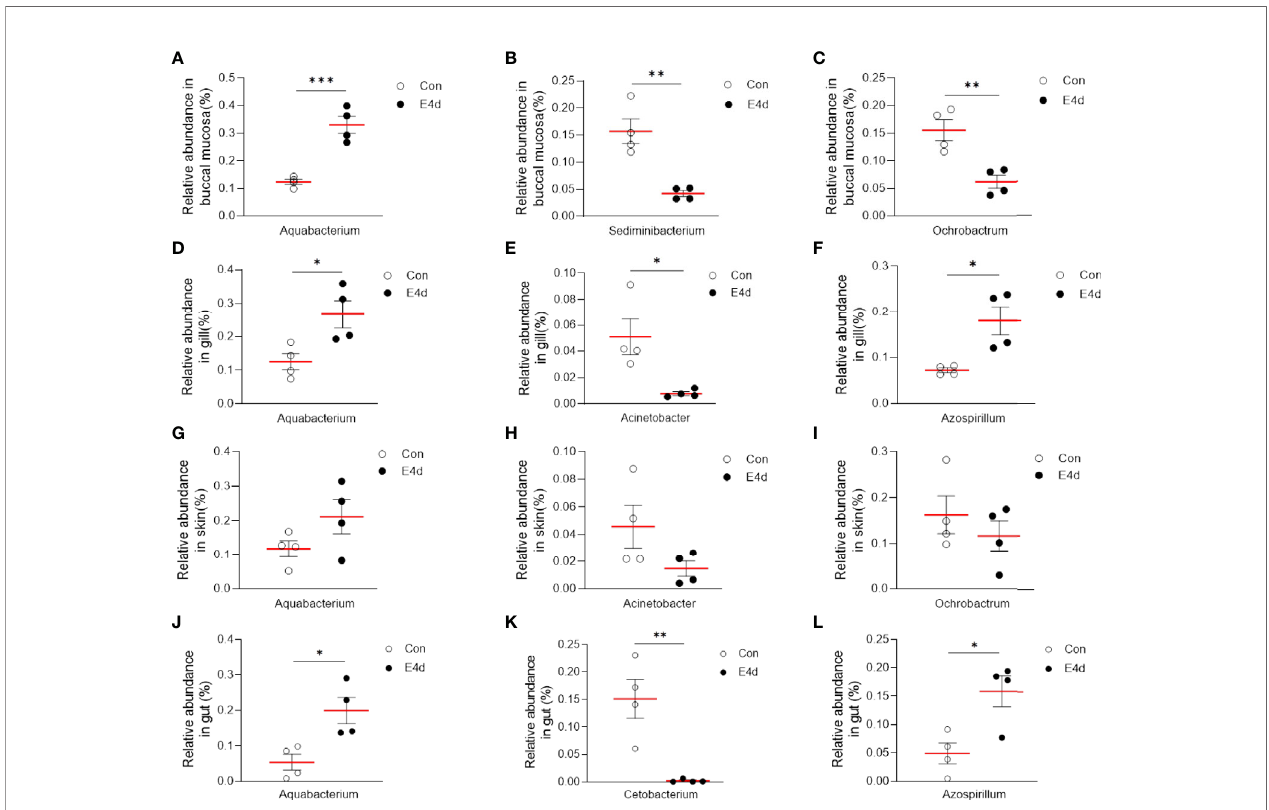
FIGURE 6 | SVCV infection results in microbial composition changes in common carp BM (A – C) , gills (D – F) , skin (G – I) , and gut (J – L) . * P < 0.05, ** P < 0.01, *** P < 0.001, unpaired Student ’ s t